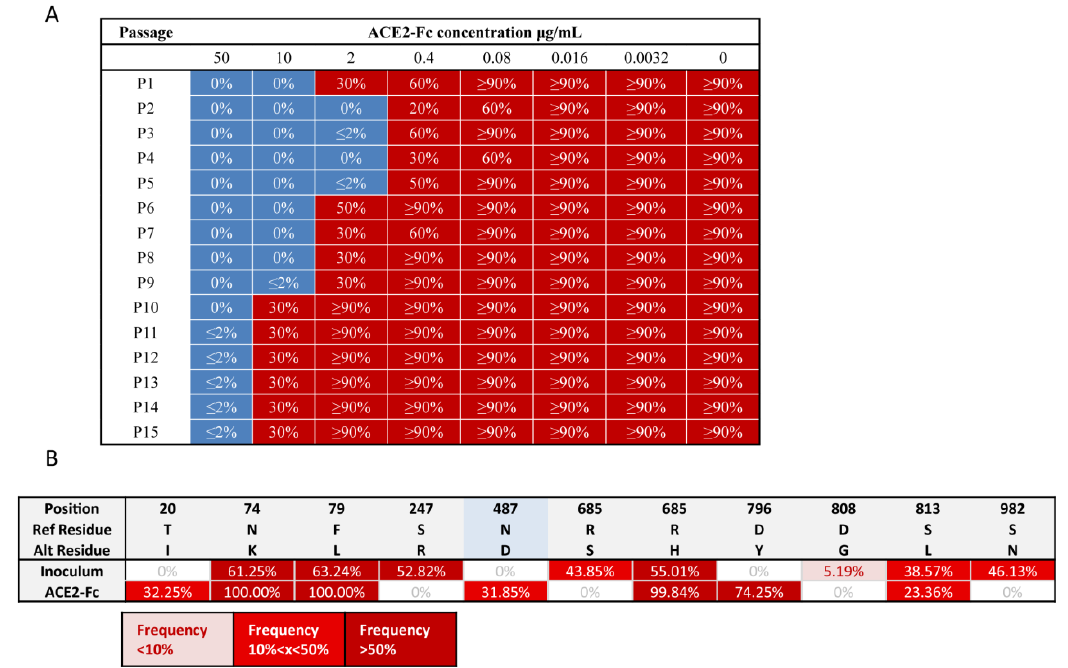
Figure 3. ACE2-Fc neutralized a replication-competent virus model that produced vast quantities of mutations on spike protein in the 45 d viral evolution. ( A ) Throughout this 45 d continual replication and evolution, VSV-SARS-CoV-2-S virus population failed to generate a variant that was able to escape ACE2-Fc. Replication-competent VSV-SARS-CoV-2-S virus was neutralized by serial concentrations of ACE2-Fc and then applied to Vero E6 cells. After 72 h, the cells were monitored for GFP expression and the suboptimal concentration of ACE2-Fc that permitted viral replication (>20% GFP-positive cells), was recorded. This viral supernatant was then incubated with serial diluted ACE2-Fc and used to infect fresh Vero E6 cells for next passage, as previously. This procedure was repeated 15 rounds (3 d/round). A representative record of GFP percentage in each well from one of two independent experiments is shown here. ( B ) Mutations on the spike proteins carried by the passage 15th viral population. RNA was extracted from the supernatant of passage 15th (p15) viral population and subjected to viral genome high-throughput sequencing using Illumina. Because of the error rate of Illumina sequencing, the prevalence of low frequency mutations (< 5%) was extremely difficult to be accurately measured. Thus, only mutations occupying over 5% viral population were shown. RBD region was highlighted in blue. Mutation N487D within the RBD was presented at 31.85% frequency in the p15 population.